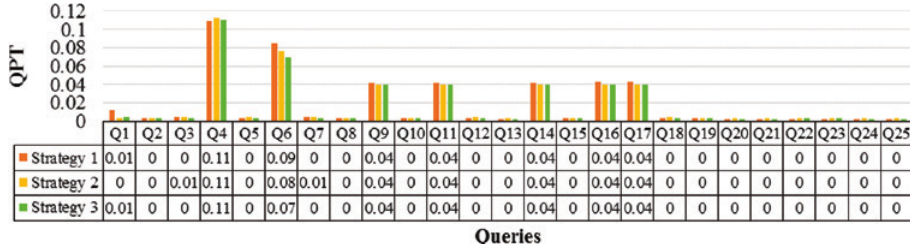
Figure 13: QPT Analysis of Three Strategies on Three Ontologies and A-BOX of Size